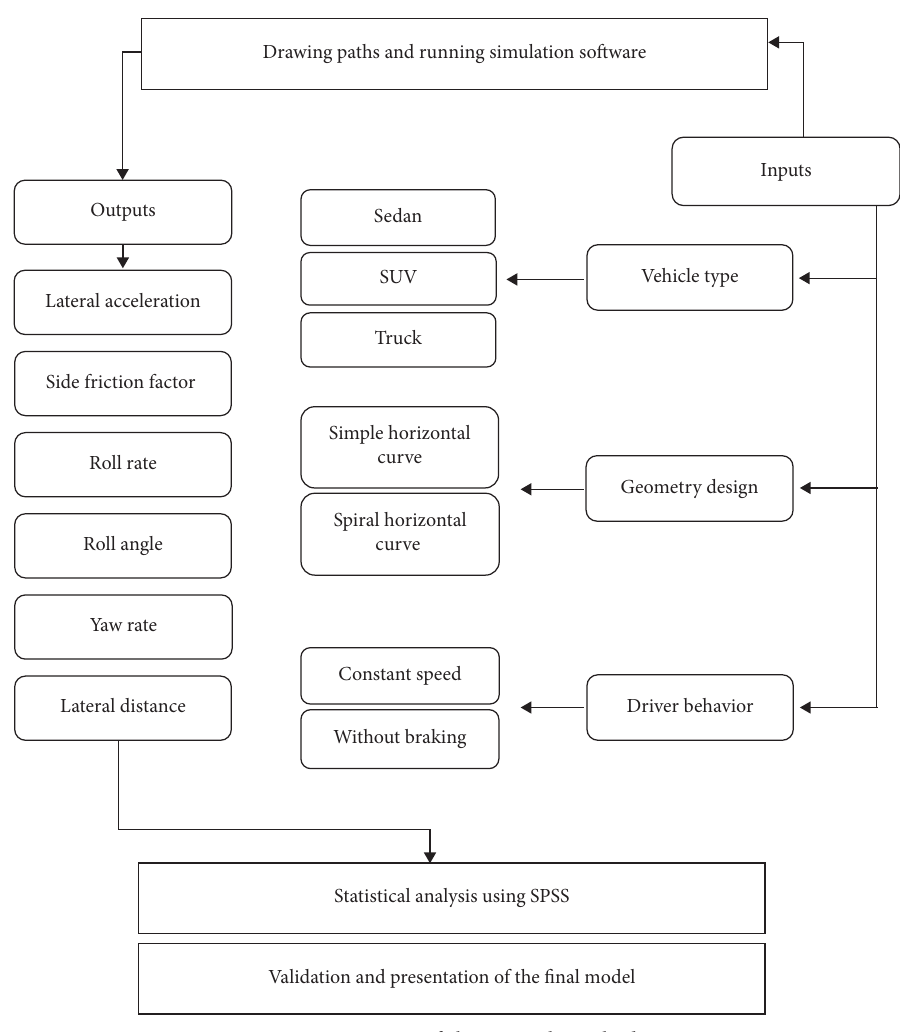
Figure 1: Steps of the research